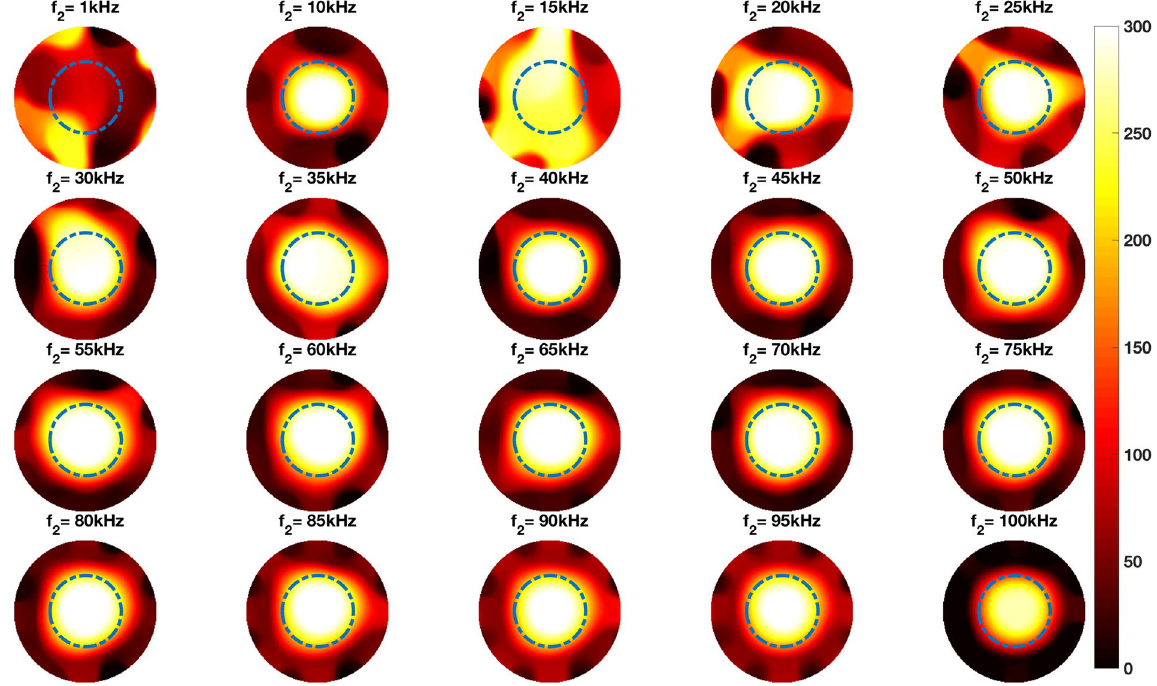
Figure 6. Reconstructed frequency difference images of a steel tube (OD50.76 mm) positioned in the centre of the imaging region (experimental setup shown in Fig.